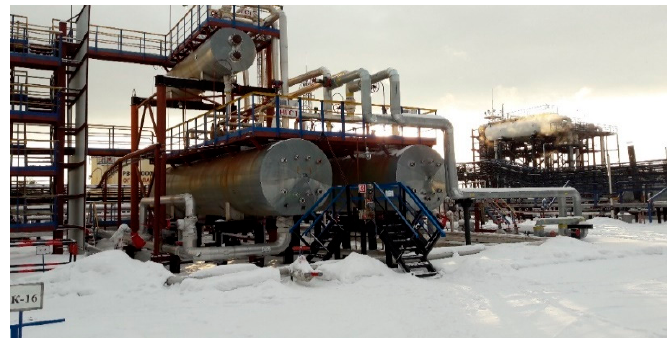
Figure 2. Crude oil preparation plant of an oil field. Table 1. Properties and composition of the oil of the studied